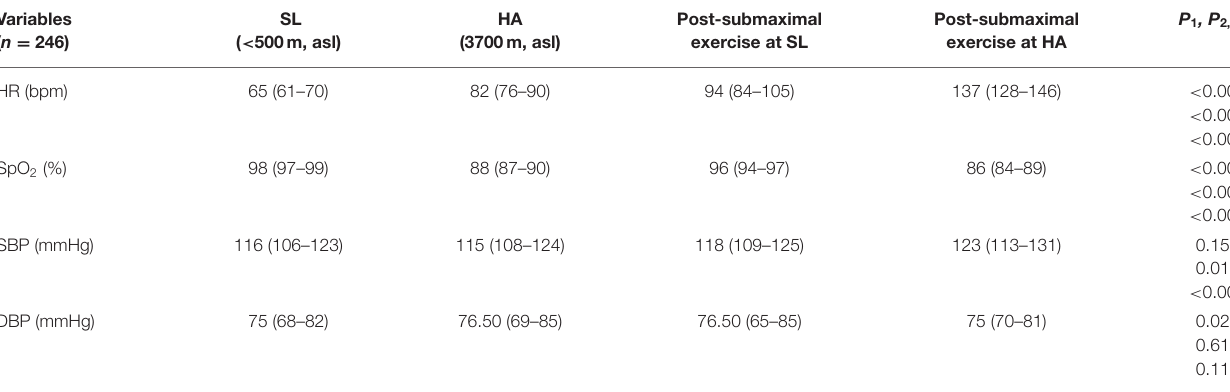
TABLE 2 | Effects of acute HA exposure on BP.